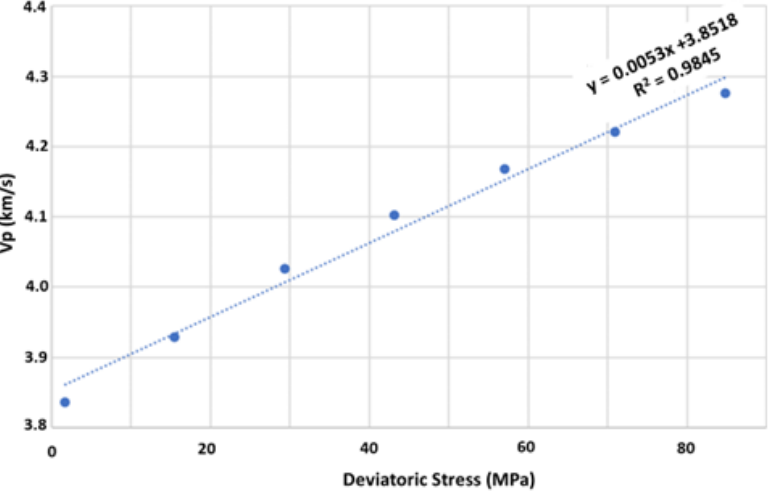
Figure 18. Change in P-wave velocity with deviatoric stress for the dry sample measurement at confining stress of 20.68 MPa of our Permian basin rock